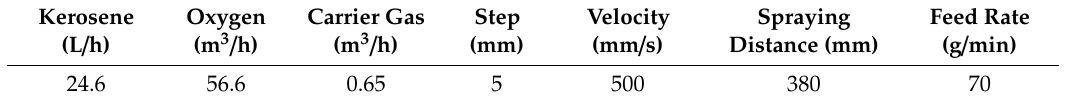
Table 2. Spraying parameters of the three WC-20Cr3C2-7Ni powders.